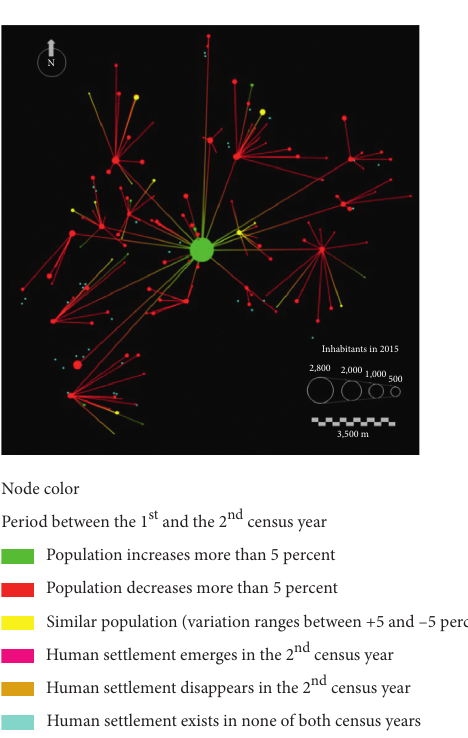
Figure 9: Population change for all the intercensal periods from 1888 to 2015. The period represented in each figure is shown in the upper right-hand corner. Node size refers to the total population in the most recent year. Node color shows the relative variation between the first and the second year in each figure. (a) 1888–1900, (b) 1900–1910, (c) 1910–1920, (d) 1920–1930, (e) 1930–1940, (f) 1940–1950,